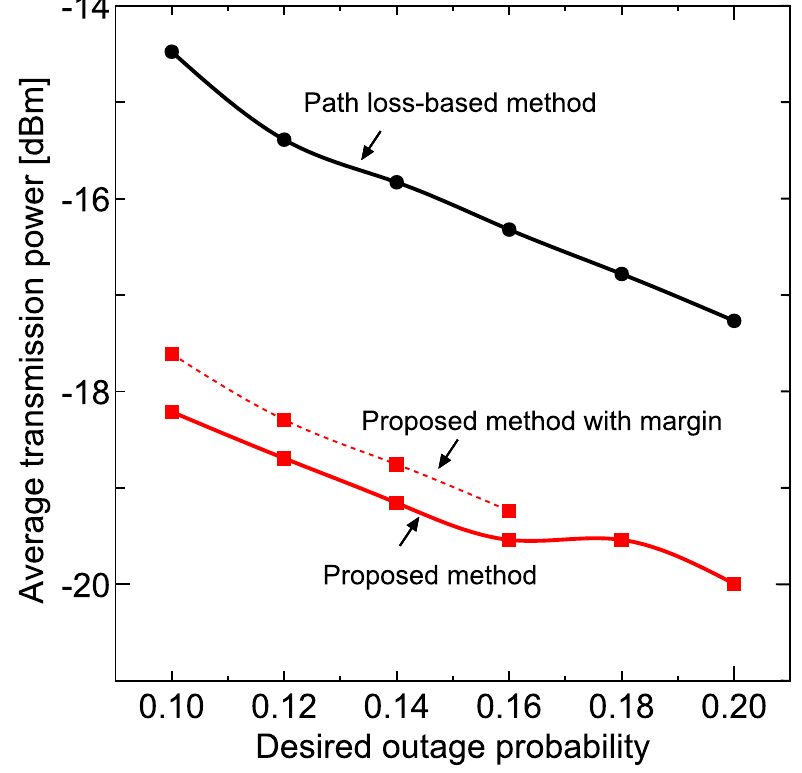
Figure 12. Average transmission